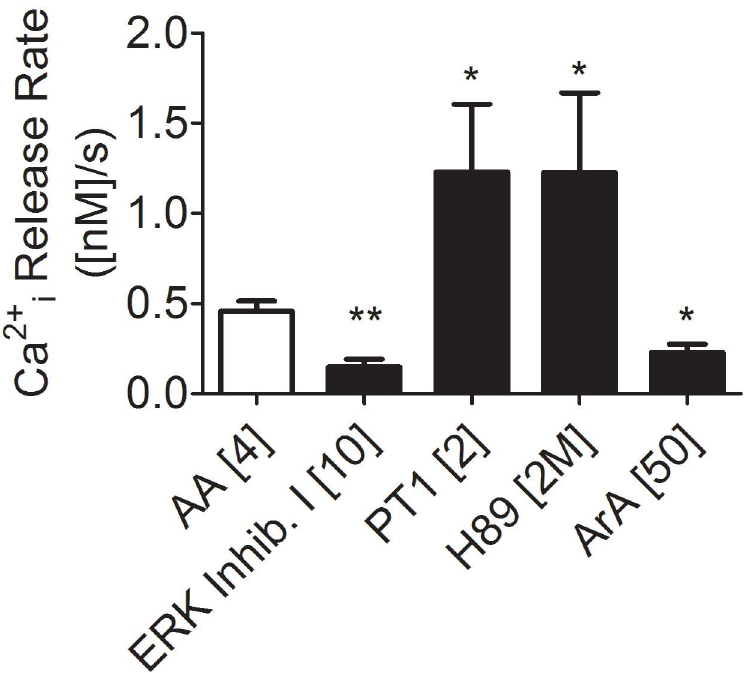
Fig 4. Pharmacological agents with a significant effect on AA-induced increasein [Ca 2+ ]i. Consolidated data showingthose pharmacologicalagents that presenteda statistically significanteffect on AA-inducedinitial rate of [Ca 2+ ]i increase. ERK inhibitorypeptideI (10 μ M); AMPK activator: PT1 (2 μ M); PKA inhibitor:H89 (2 μ M); Inhibitor of PLA2: Aristolochicacid (ArA, 50 μ M) Significance: * , p < 0.05; ** , p < 0.01. Error bars represent the standarddeviationfrom at least 3 different cell preparations. The effects of all the signalling pathways effectors utilizedin this work are shown in (S3A, S3B, S3C and S3D Fig).